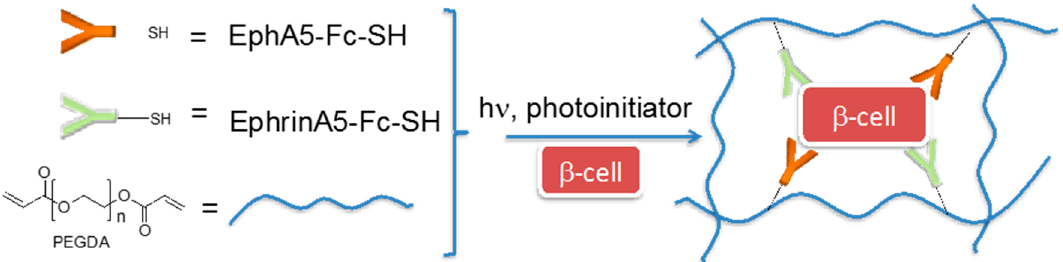
Figure 2. Schematic representation of poly(ethylene glycol) (PEG)-based hydrogels conjugated to EphA5-Fc and EphrinA5-Fc, tailored to sustain pancreatic β -cells survival.